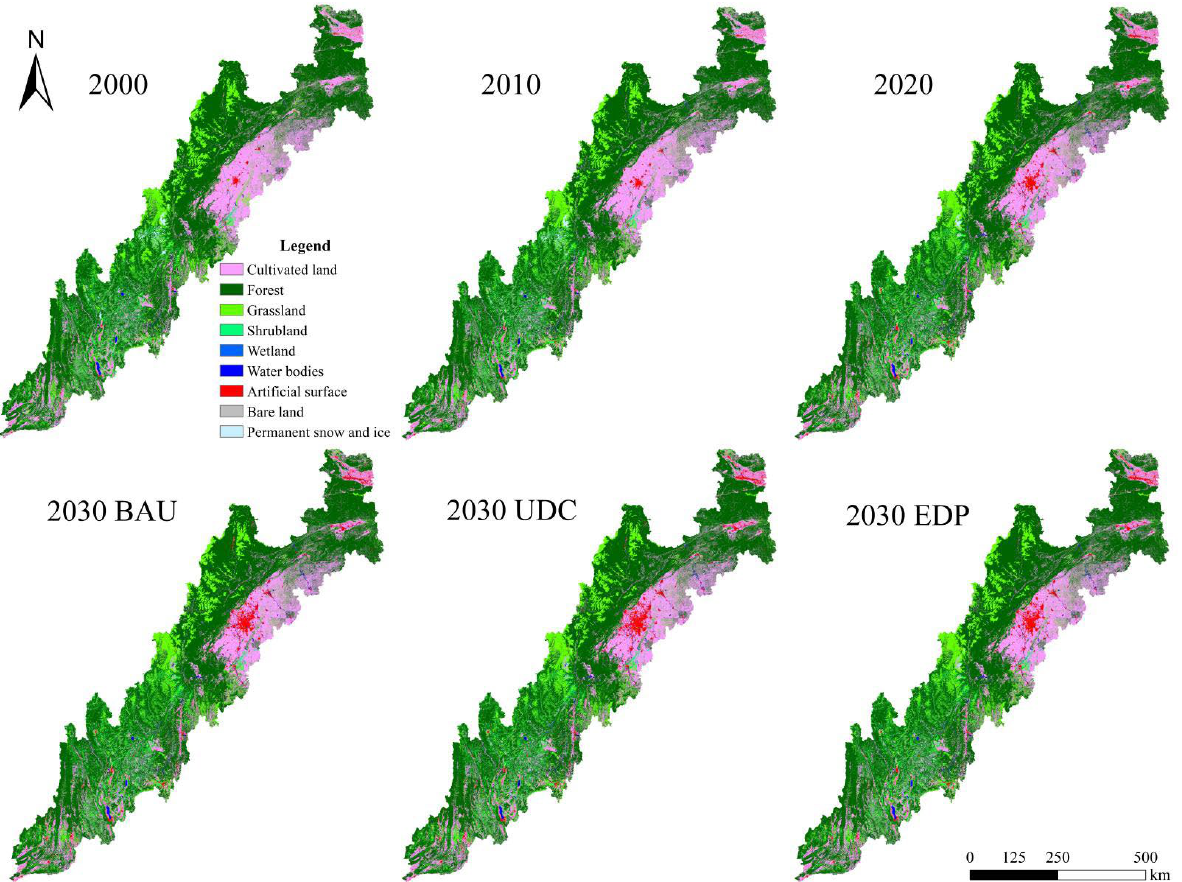
Figure 2. Land use and land cover in the Sichuan-Yunnan Ecological Barrier in 2000, 2010, and 2020 and three scenarios (BAU/UDC/EDP).